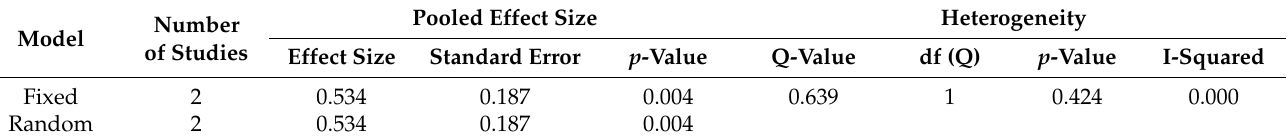
Table 17. Heterogeneity test results of studies on the influence of indoor plants on academic achievement.